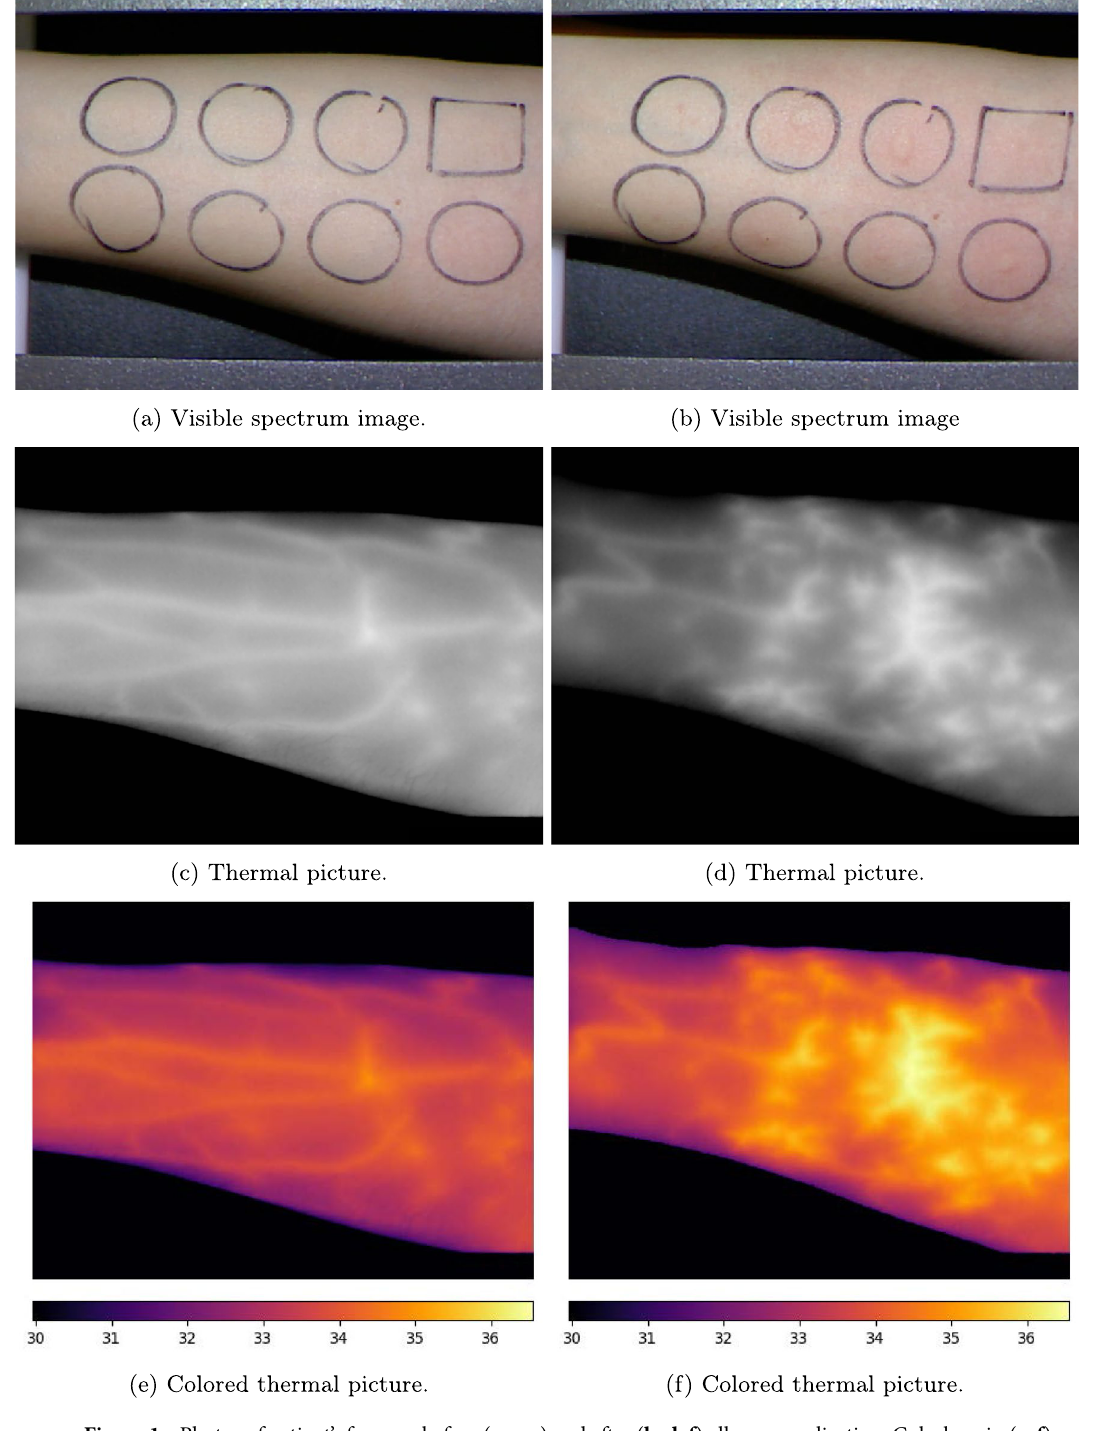
Figure 1. Photos of patient’s forearm before ( a , c , e ) and after ( b , d , f ) allergen application. Colorbars in ( e , f ) show the temperature scale in Celsius